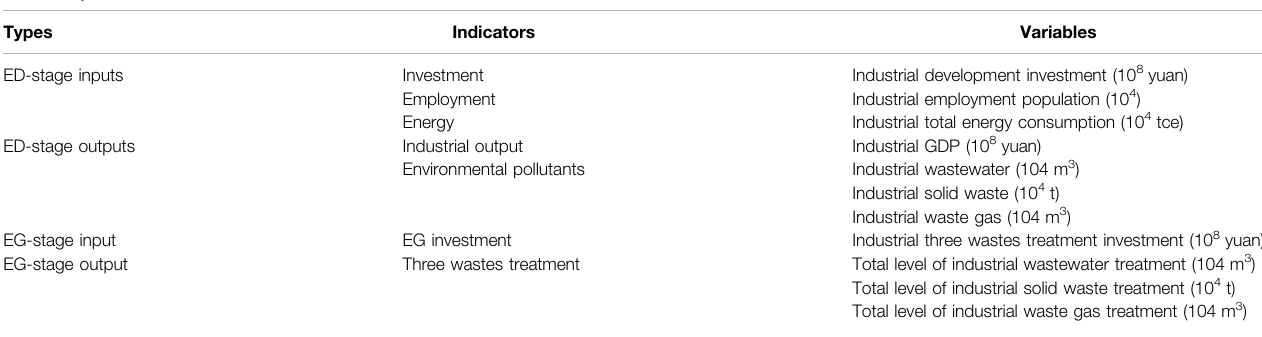
TABLE 1 | Indicators for the IEE assessment